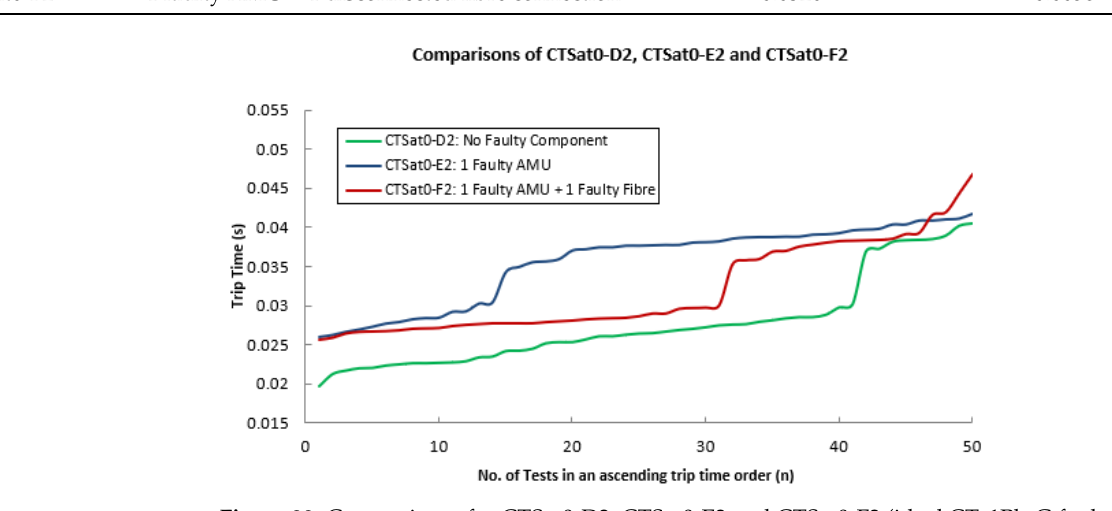
Figure 29. Comparisons for CTSat0-D2, CTSat0-E2 and CTSat0-F2 (ideal CT, 1Ph-G fault at 70% of the feeder). Table 10. Trip times for single-phase-to-ground fault.